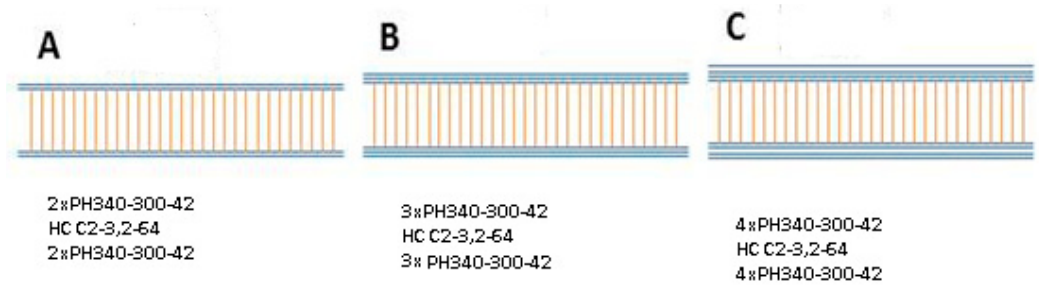
Figure 2. Constructions of basic samples. A : Honeycomb C2-3.2-64 is coated with two layers od PH340-300-42 coatings on both sides; B : Honeycomb C2-3.2-64 is coated with three layers od PH340-300-42 coatings on both sides; C : Honeycomb C2-3.2-64 is coated with four layers od PH340-300-42 coatings on both